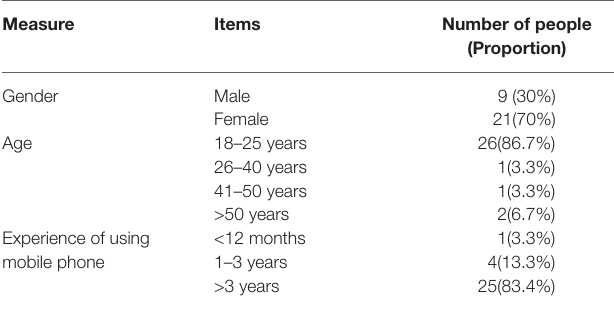
TABLE 6 | Demographic information of participants in sample 2 ( N = 30). Measure